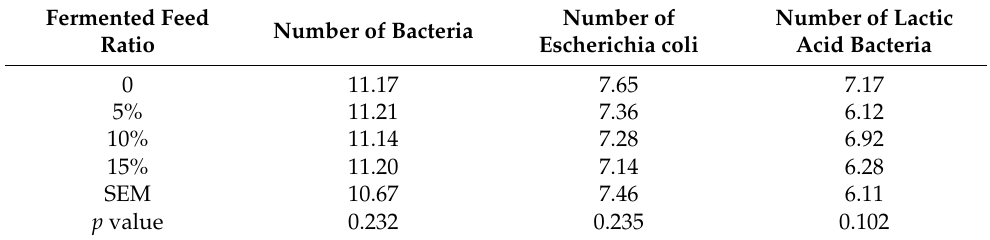
Table 9. The effect of fermented feed on the cecal microorganisms of broilers lg